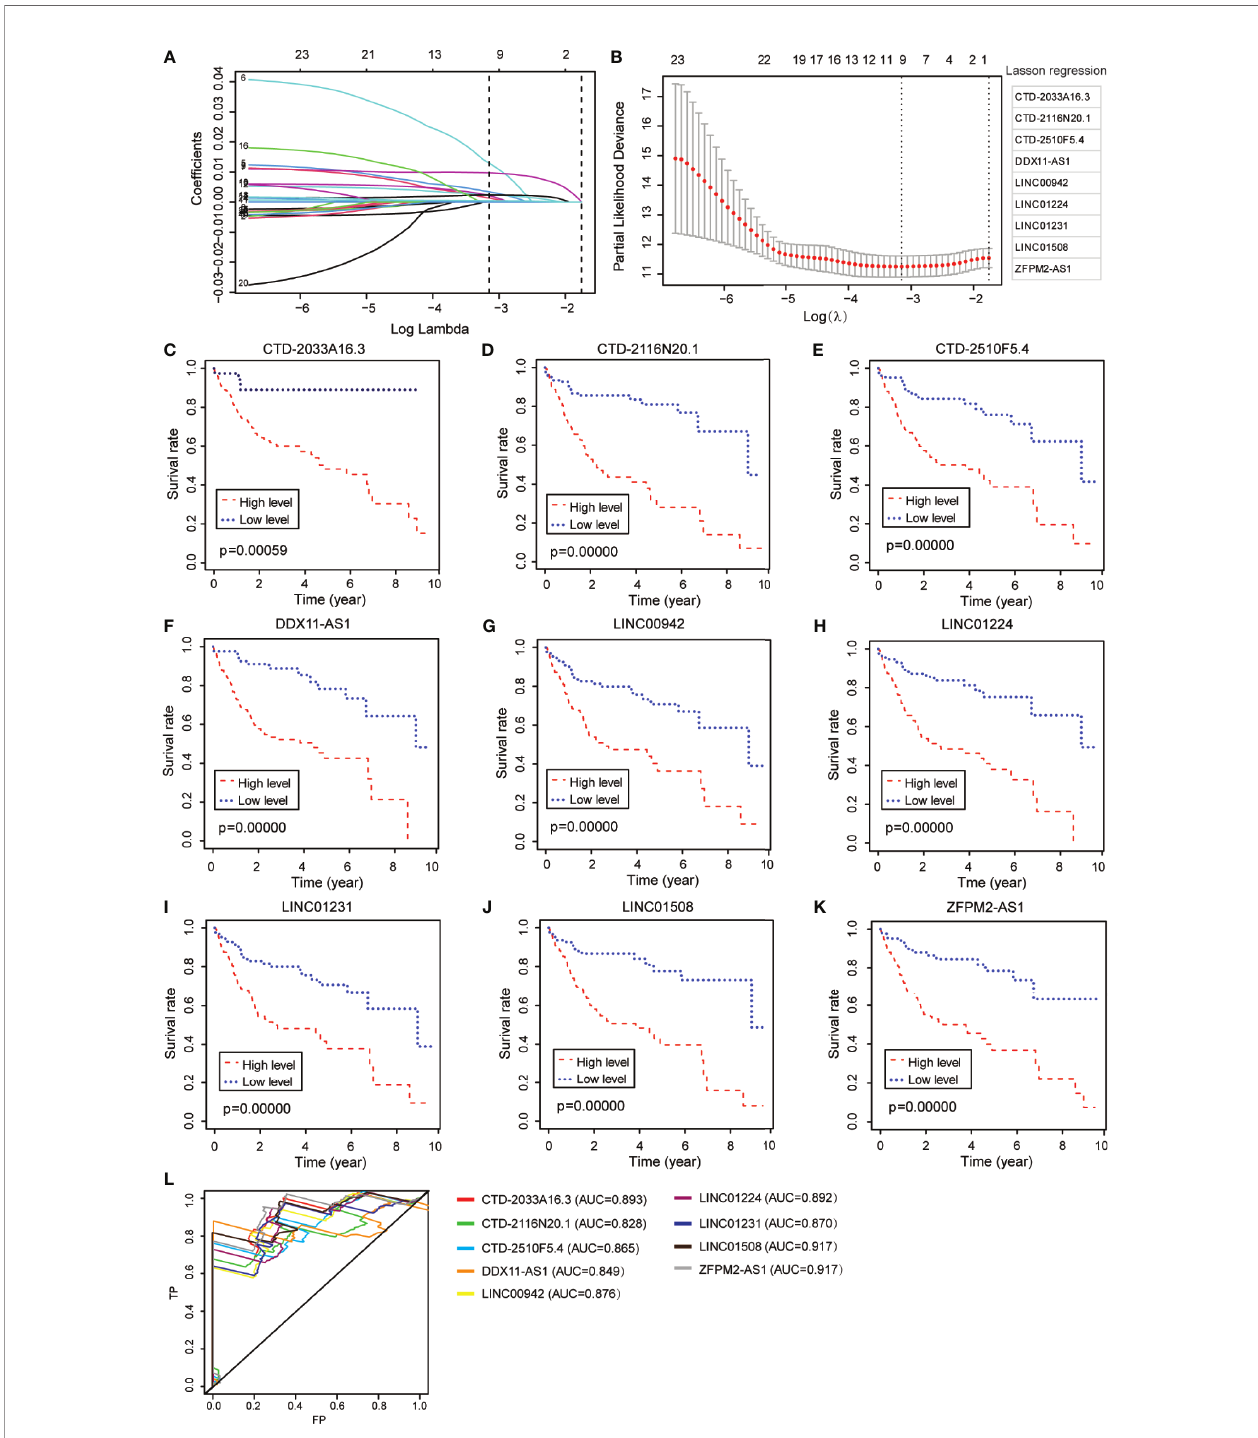
FIGURE 2 | Identi fi cation of ferroptosis-associated nine-lncRNAs with prognostic value in hepatocellular carcinoma (HCC) patients. (A, B) LASSO Cox regression with a 10-fold cross-validation for the prognostic value of the ferroptosis-associated nine-lncRNAs, including CTD-2033A16.3, CTD-2116N20.1, CTD-2510F5.4, DDX11-AS1, LINC00942, LINC01224, LINC01231, LINC01508, and ZFPM2-AS1. (C – K) Kaplan – Meier analytical evaluation of the prognostic values of the candidate lncRNAs. (L) Time-dependent receiver operating characteristic curves for the prognostic model based on the expression of nine-lncRNAs in The Cancer Genome Atlas – HCC